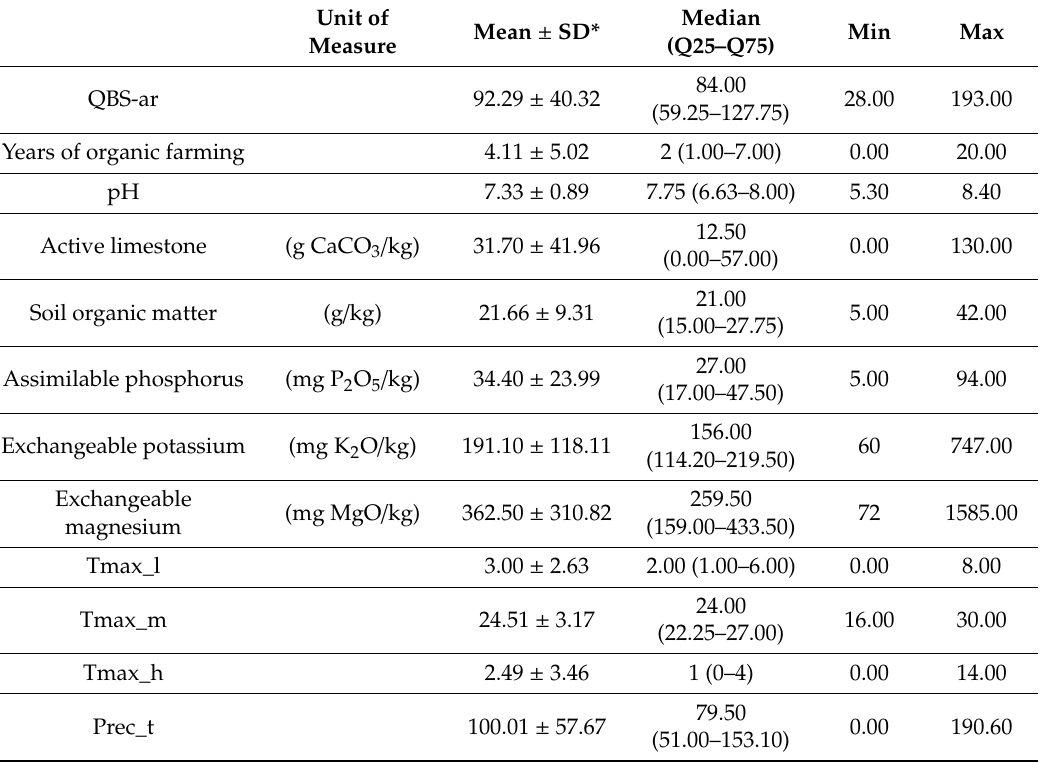
Table 2. Descriptive statistics for quantitative variables in the